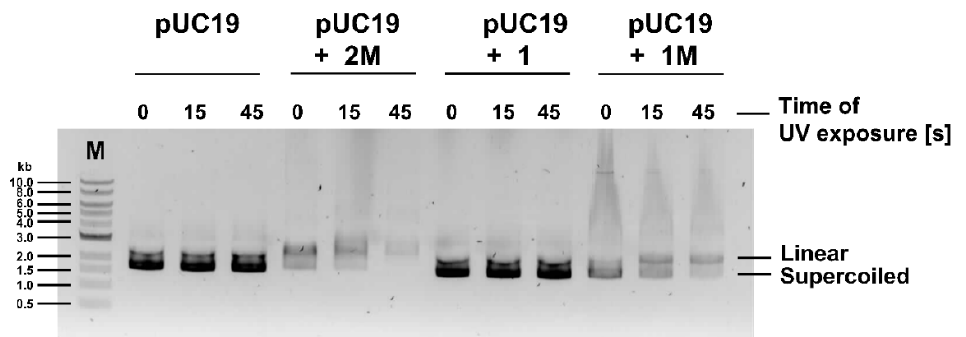
Figure 6. Representative agarose gel of pUC19 plasmid DNA incubated with 2M , 1 , or 1M , with or without exposure to UV light (15 or 45 s). M–GelPilot DNA Molecular Weight Marker 1kb. Representative data from two independent experiments that yielded similar results are shown.